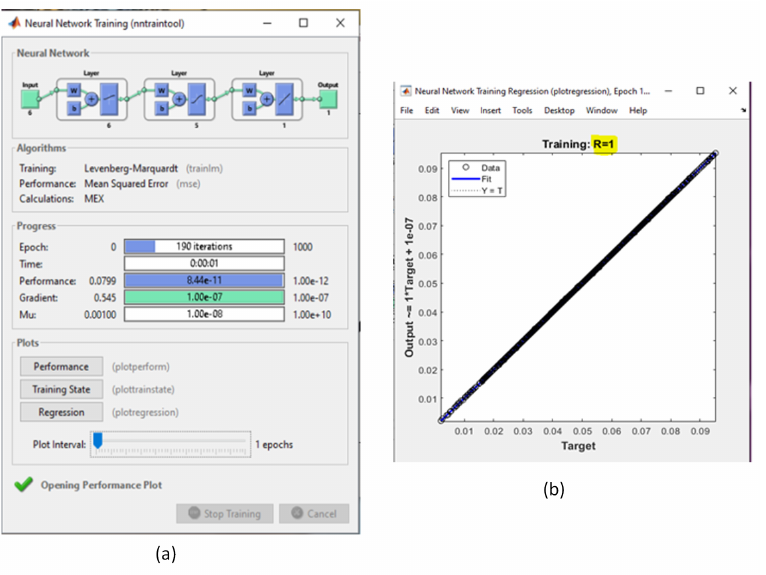
Figure 8. Artificial neural network results.